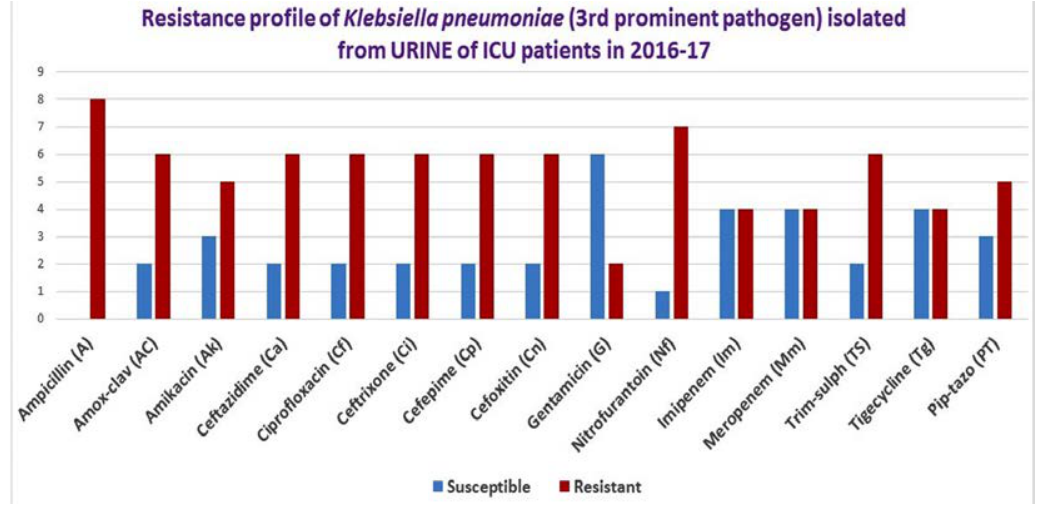
Fig. 6. Antimicrobial susceptibility trend of Klebsiella pneumoniae cultured from urine of ICU patients (2016-2017)